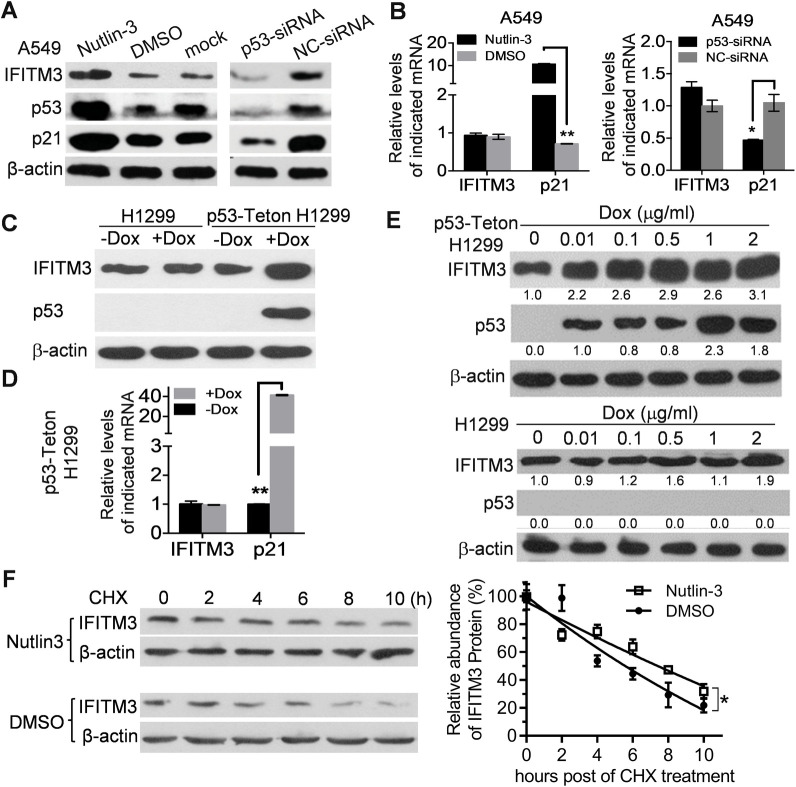
p53 up-regulates IFITM3 protein expression.(A and B) A549 cells were treated with 20 μM Nutlin-3 for 24 h or transfected with p53-siRNA for 48 h, IFITM3 and p21 protein abundance was detected by western blot (A) and mRNA levels were detected by qRT-PCR (B). (C and D) H1299 and p53-Teton H1299 cells were treated with 1 μg/ml Dox (+Dox) for 24 h, IFITM3 protein and mRNA level were measured by western blot and qRT-PCR. (E) H1299 and p53-Teton H1299 cells were treated with Dox at different dose for 48 h, IFITM3 and p53 protein expression were detected with western blot. (F) HCT116 cells were treated with Nutlin-3 for 24 h and subsequently subjected to 200 μg/ml CHX incubation, the cells were harvested at the indicated times for western blot analysis (left panel). Relative IFITM3 protein levels normalized to β-actin were presented relative to the level (set as 100) at 0 h post-CHX treatment (right panel). Unpaired t test, *P<0.05; **P<0.01.